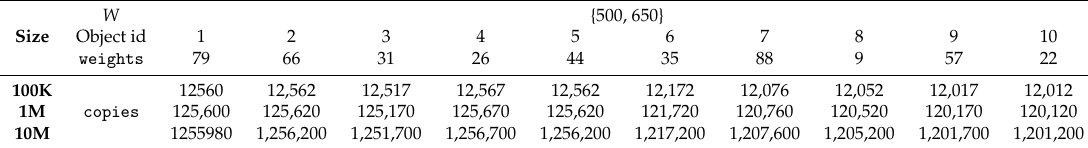
Table 6. Parameters used for the casting scheduling problem. Note that the crucible size, W , and the weights are in common for all the problem dimensionalities, therefore the only parameter that changes across dimensionalities is the number of copies per object.